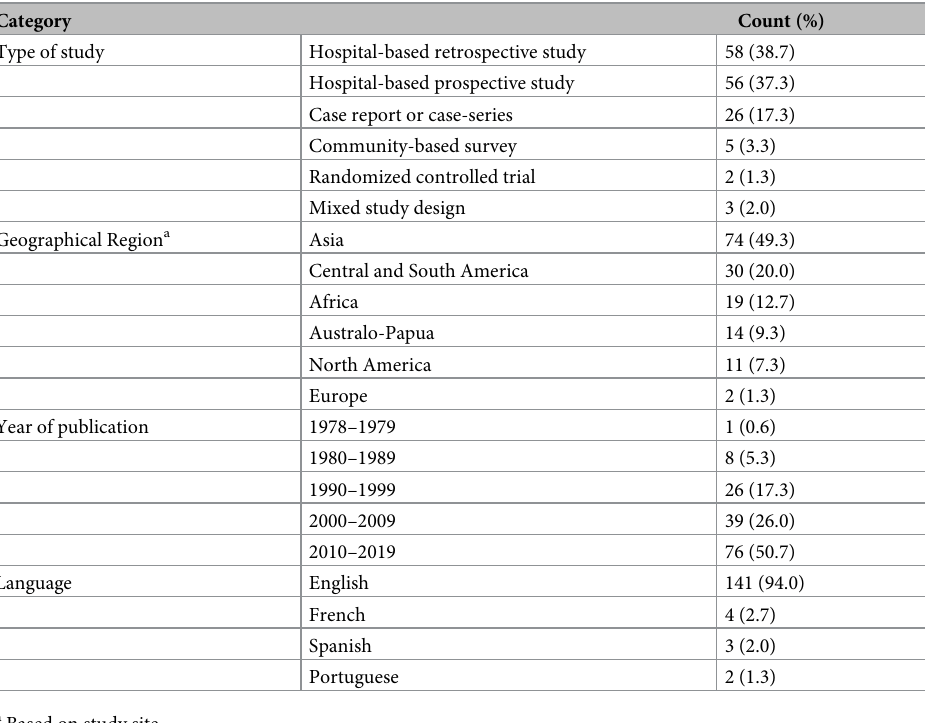
Table 1. General characteristics of included publications (number of publications =